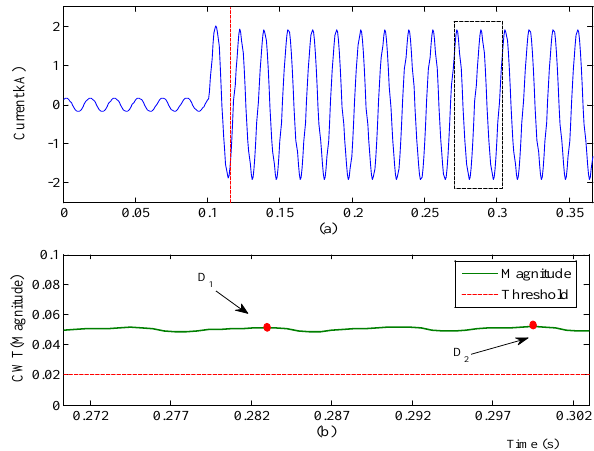
Figure 8. Permanent Fault event in (13-Bus) is detected and classified, ( a ) I n ; ( b ) D 1 and D 2 of the normalized I n in the 11th–12th